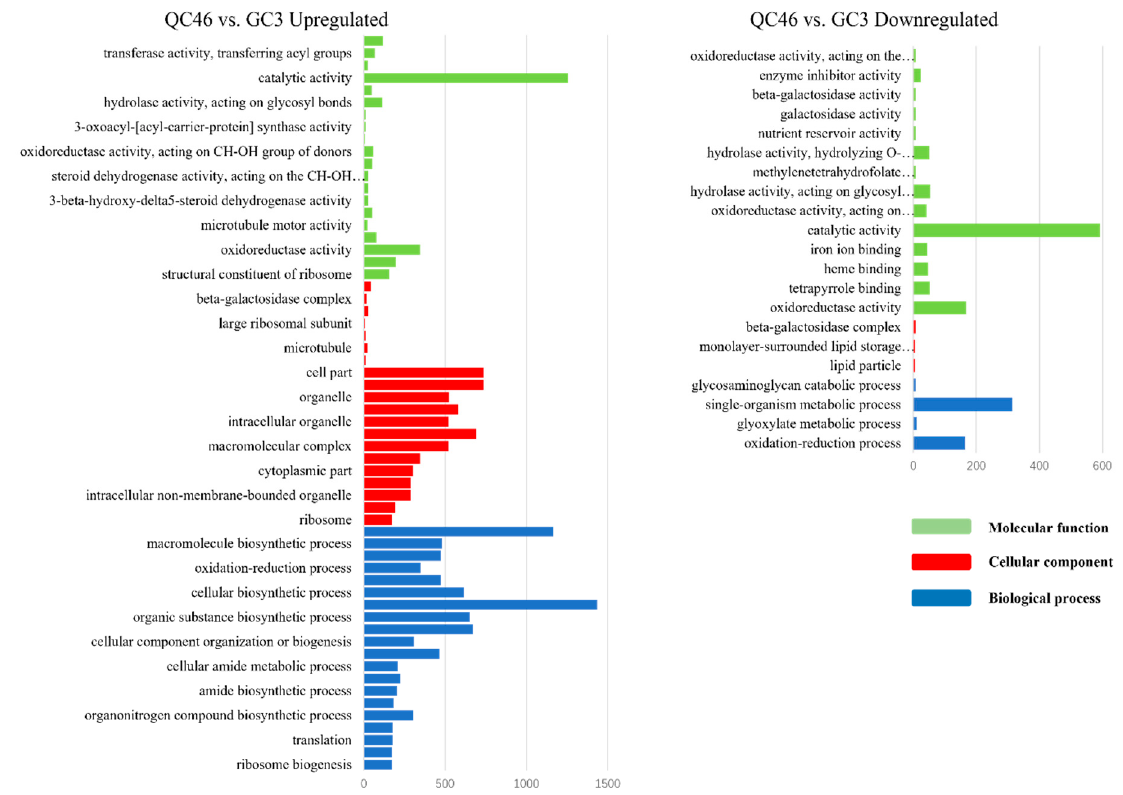
Figure 6. GO annotation of differentially expressed genes (DEGs) in the QC46 vs. GC3 comparison. The blue, red, and green columns represent the biological process (BP), cellular component (CC), and molecular function (MF), respectively.